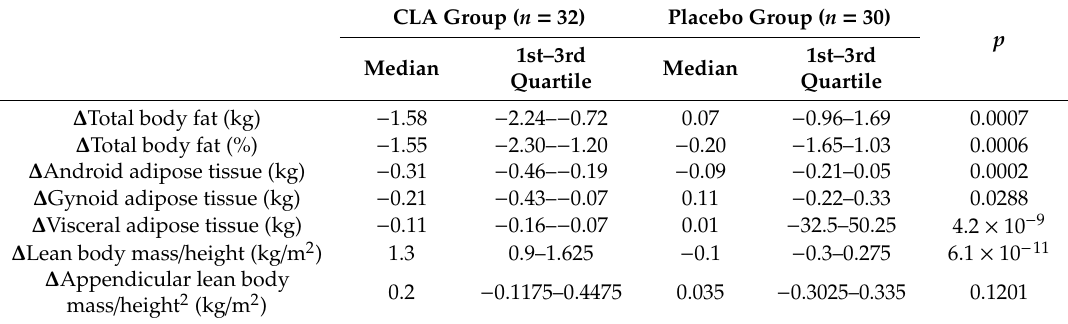
Table 3. E ff ects of conjugated linoleic acid (CLA) and placebo on body composition outcome measures.